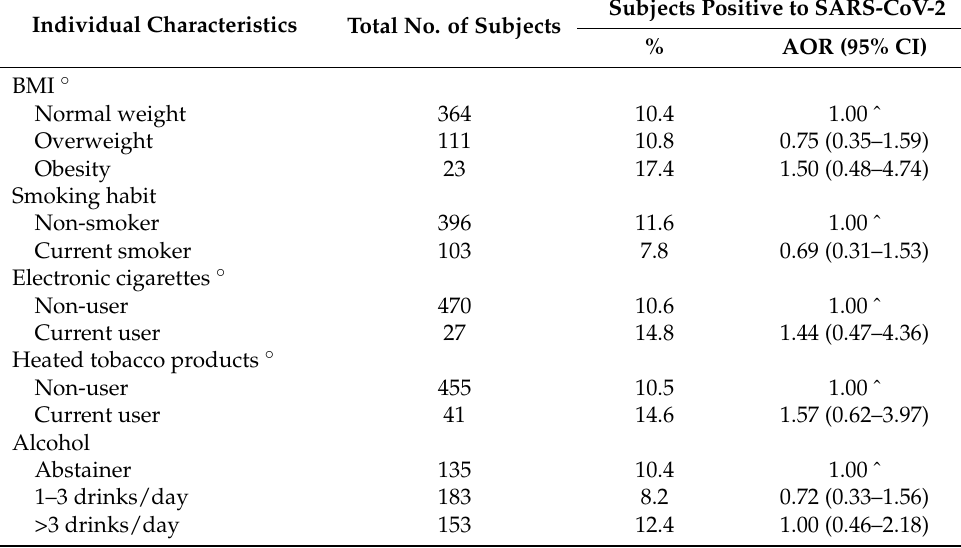
Table 3. Distribution of 499 workers in dentistry with valid test, by SARS-CoV-2 positivity, overall and according to selected lifestyle habits. Corresponding adjusted odds ratios * (AOR) and 95% confidence intervals (CI). Lombardy region (Italy),